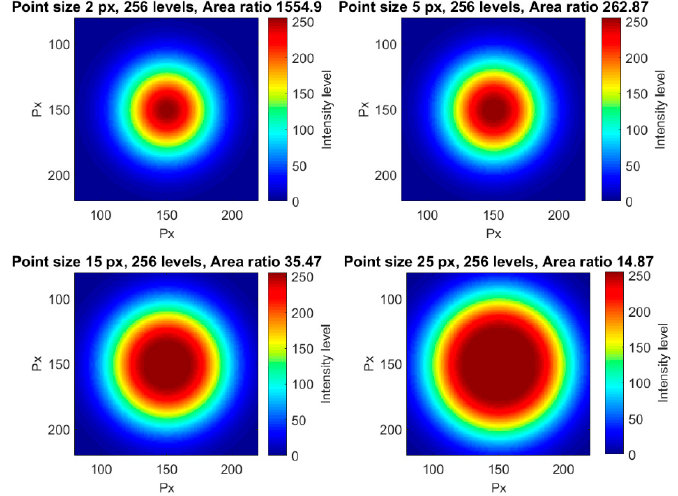
Figure 9. Four different examples of points with different point sizes and the same number of levels.